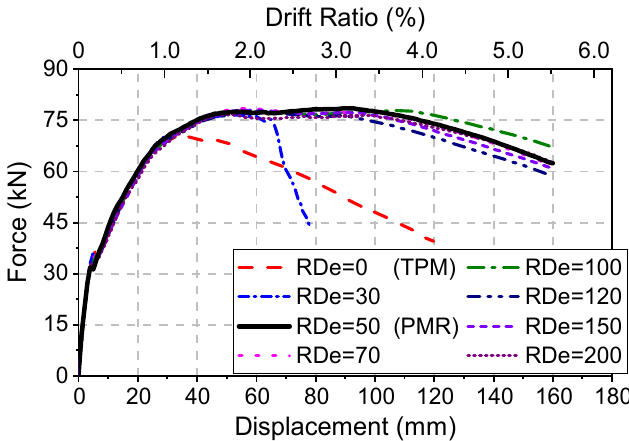
Figure 17. Force–displacement relation with different recess depths. Ultimate displacements (the displacement when loading capacity decreases to 85% of its maximum value) of all models are listed in Table 1. Ultimate displacement of models with RDe values over 50 mm is approximately twice of models with 0 mm and 30 mm depth. Generally, the ultimate displacements of the models increase with recess depth, gradually approaching CIPM’s value. Table 1 also gives the comparison of resisting forces. The lateral strength of pier keeps rising with the recess depth until 50 mm. Compared with CIPM, strengths of the models with RDe values over 50 mm are only off by 5%. Table 1. Ultimate displacements and forces of the models with different recess depths.